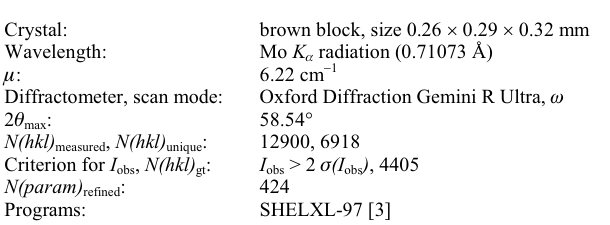
Table 1. Data collection and handling.